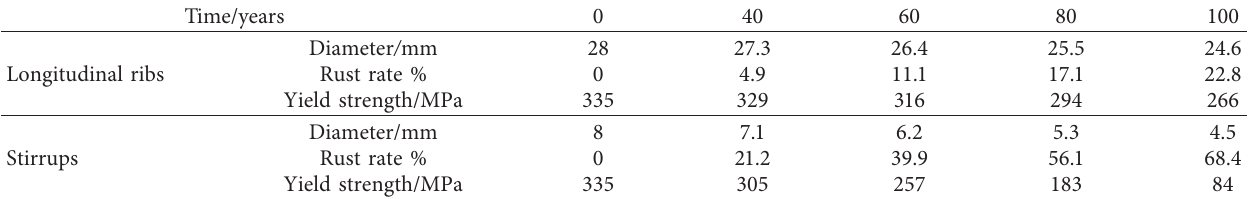
Table 3: Analysis of corrosion deterioration of reinforcing steel at various